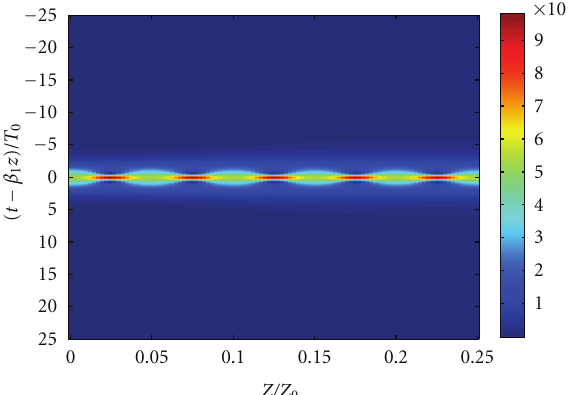
Figure 3: Temporal evolution at propagation distance of 25-cm for pump wavelength λ = 850 nm. Kerr nonlinearity and dispersion are taken into account.